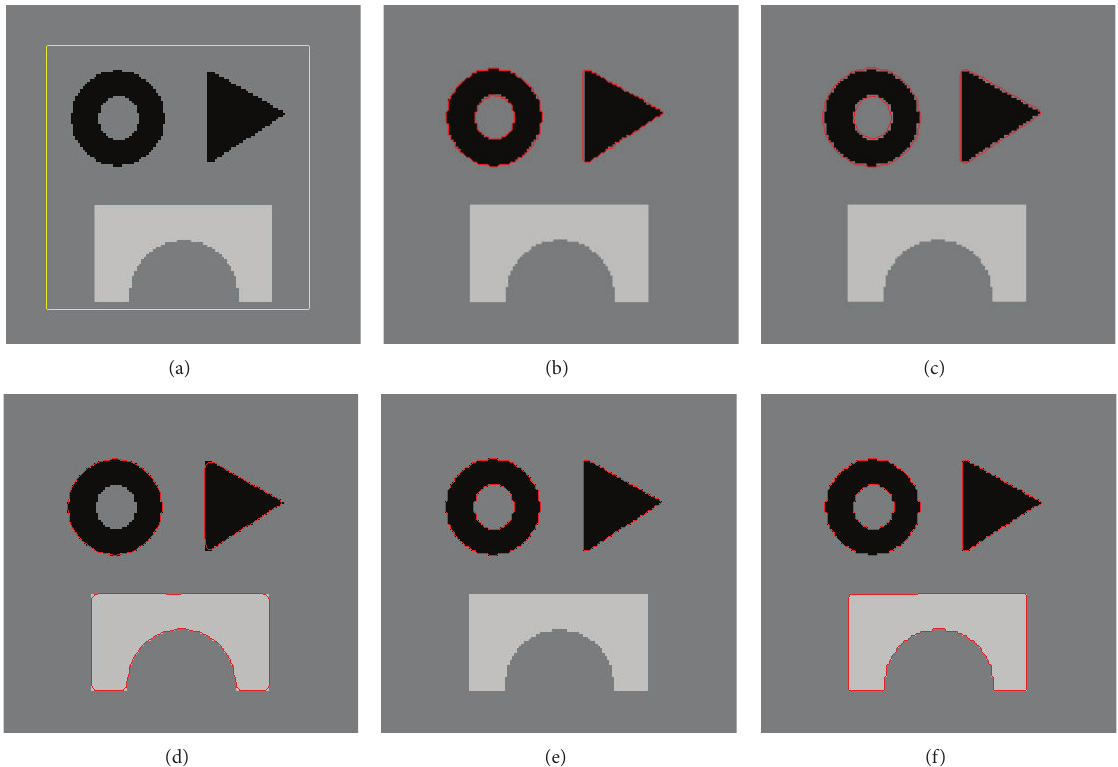
Figure 6: Segmentation results on a synthetic image: (a) the initial contour, (b) the CV model result, (c) the GACV model result, (d) the DRLSE model result, (e) the FAC model result, and (f) the LFAC model result.